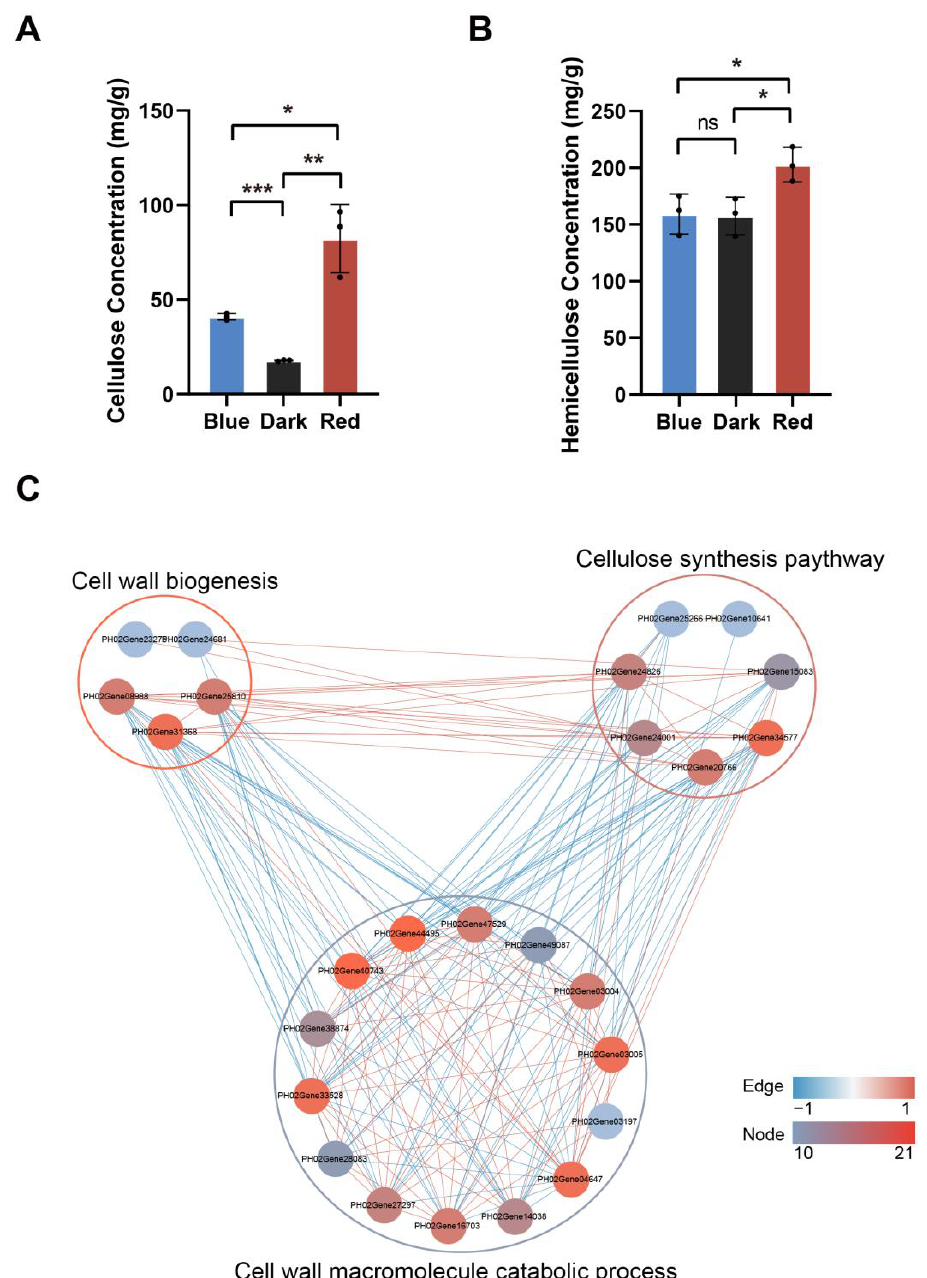
Figure 9. Compared to blue light, red light promotes the formation of cell wall components in moso bamboo seedlings. ( A , B ) Cellulose ( A ) and hemicellulose ( B ) contents of moso bamboo seedlings under different light conditions. Data are presented as mean ± SD ( n = 3 biological replicates). Significant differences were analyzed by two-tailed Student ’ s t -test ( ns p > 0.05, * p < 0.05, ** p < 0.01, *** p < 0.001). ( C ) Correlation analysis of DEP expression levels between cell wall biogenesis, cell wall macromolecule catabolic process and cellulose synthesis pathways. The color of the node indicates the number of proteins with co-expression relationships (from left to right, the color bar indicates the number of proteins increases in turn), and the connecting lines indicate a significant co-expression relationship between the two connected proteins. The color of the line connecting two proteins is used to indicate the correlation between the proteins. The color of the line is between 0 and 1, indicating that there is a positive correlation between the two proteins. Contrarily, it shows that there is a negative correlation between the two proteins.